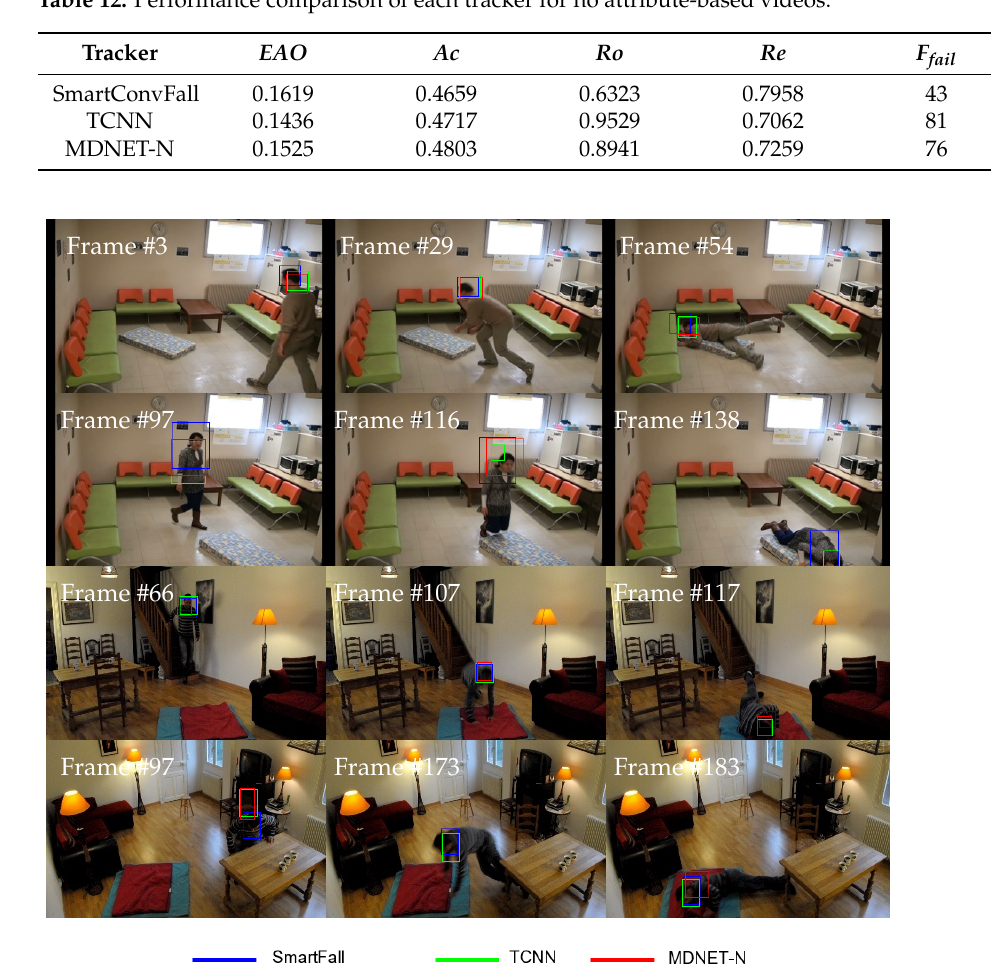
Figure 17. Comparison of B output of all tested trackers for no-attribute